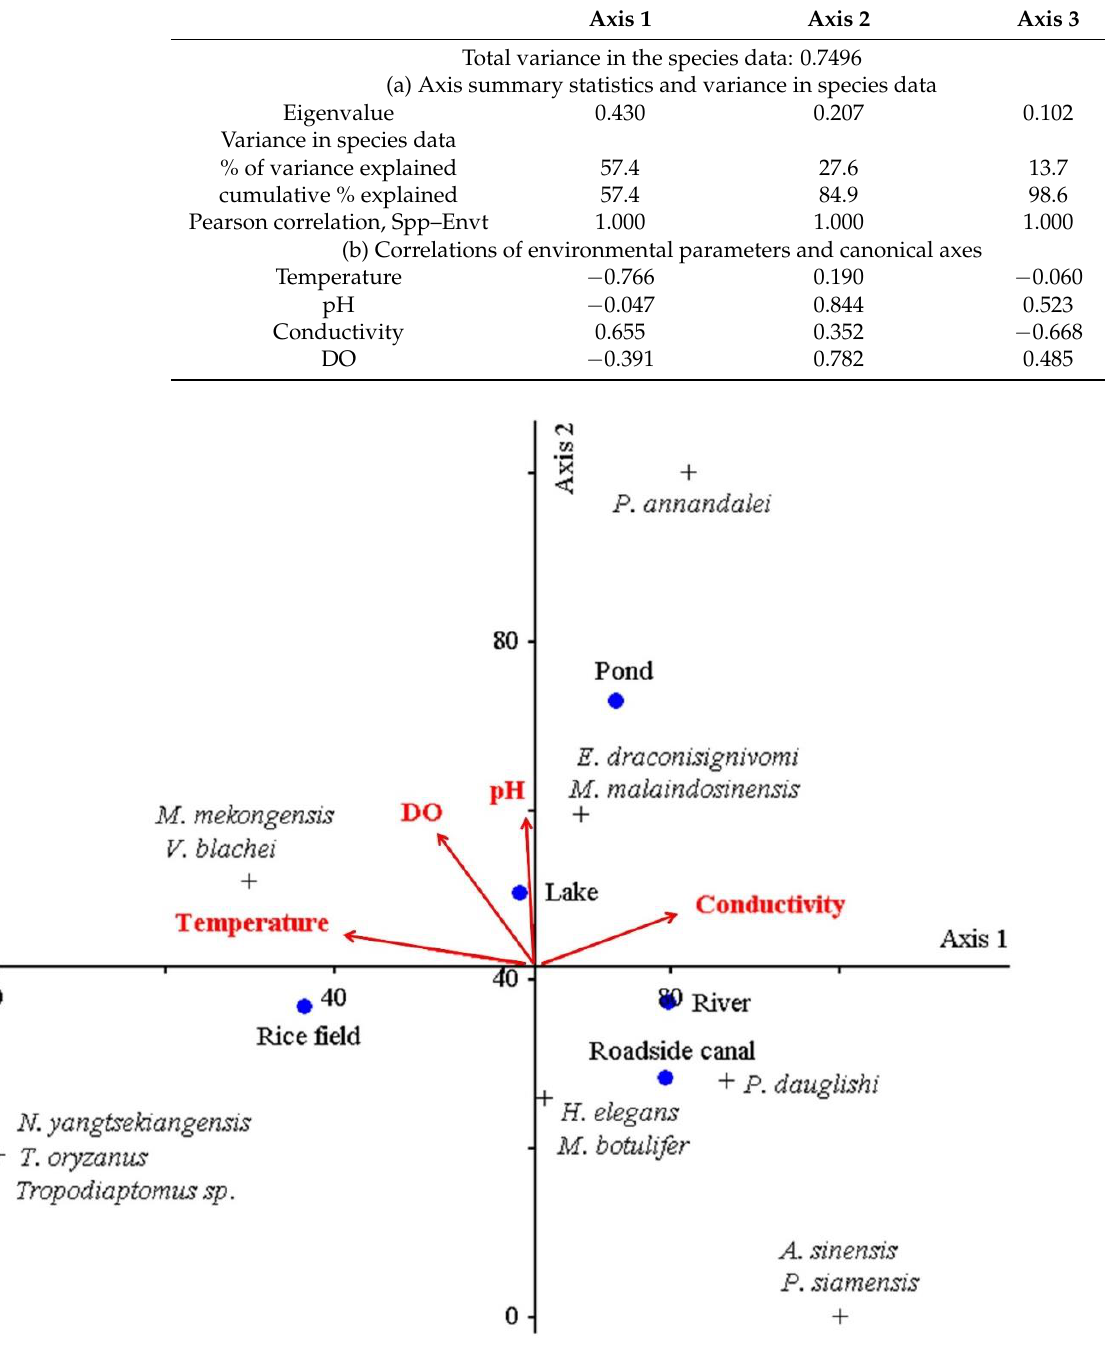
Table 4. Canonical correspondence analysis for environmental variables. ( a ) Axis summary statistics for the three extracted canonical axes, as well as the percentage of variance explained by CCA ordination. ( b ) The relationship between environmental variables and ordination axes.